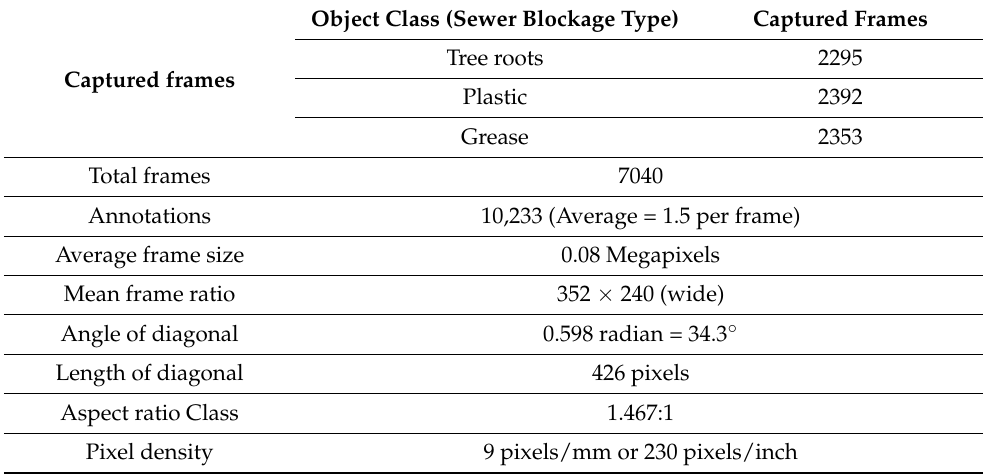
Table 2. Arithmetical details of captured frames.